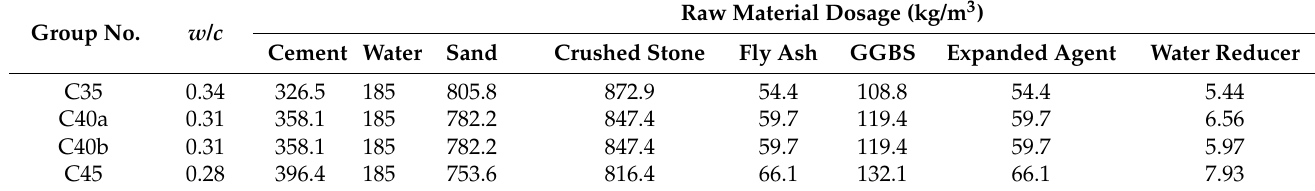
Table 2. Results of mix proportion of